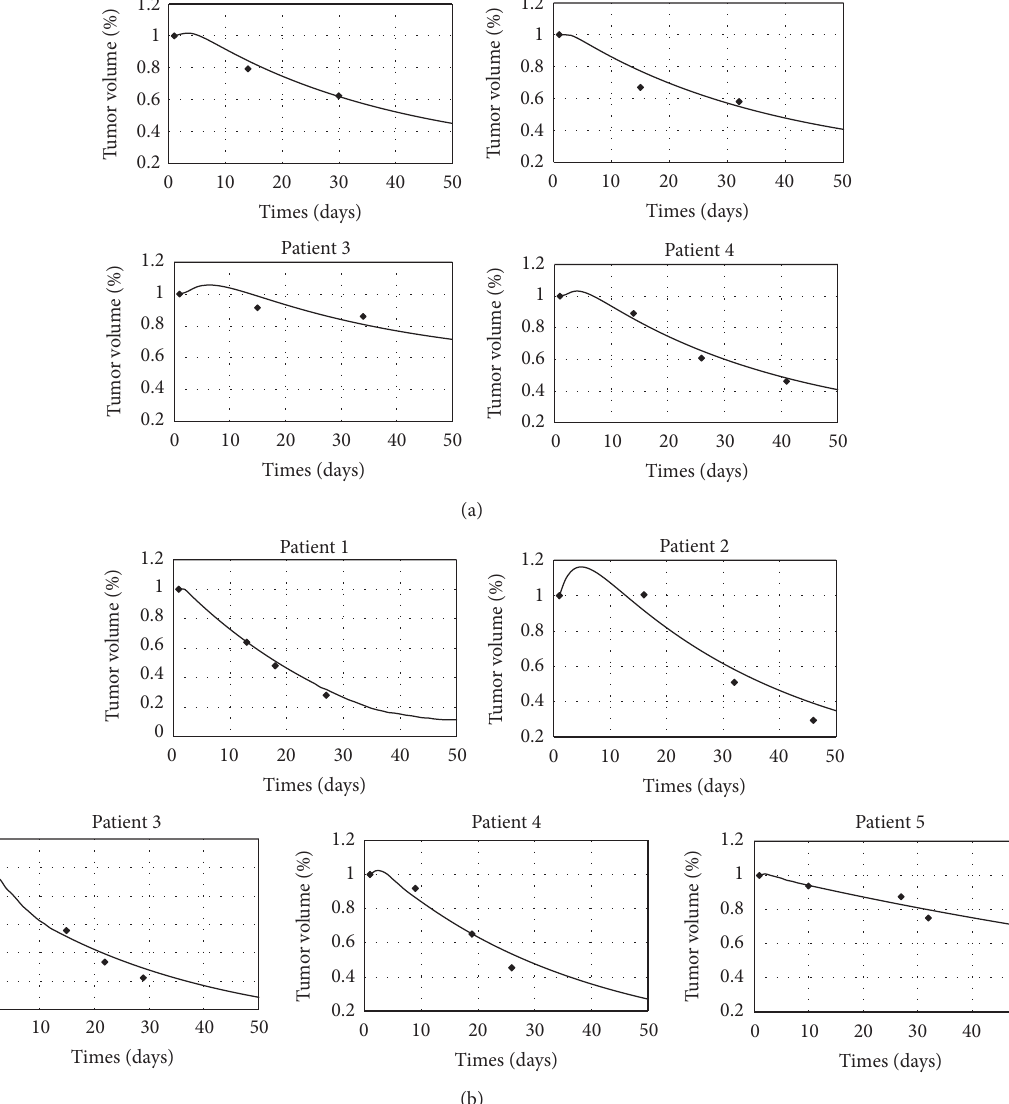
Figure 2: Measured (symbols) and modeled results (solid lines) of the tumor volumes. (a) Lung cancer cases, (b) cervical cancer cases.